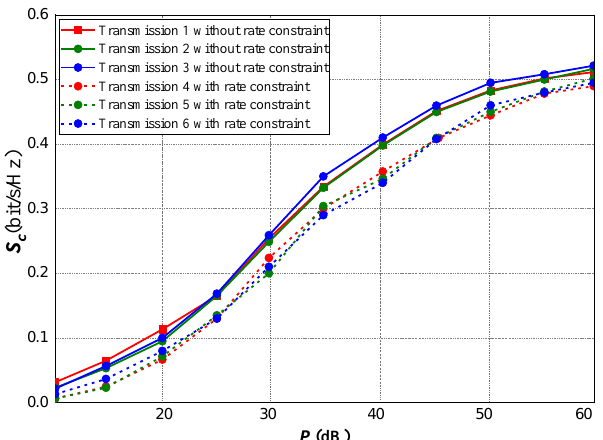
Figure 5. Maximum realized privacy capacity for multiple destinations